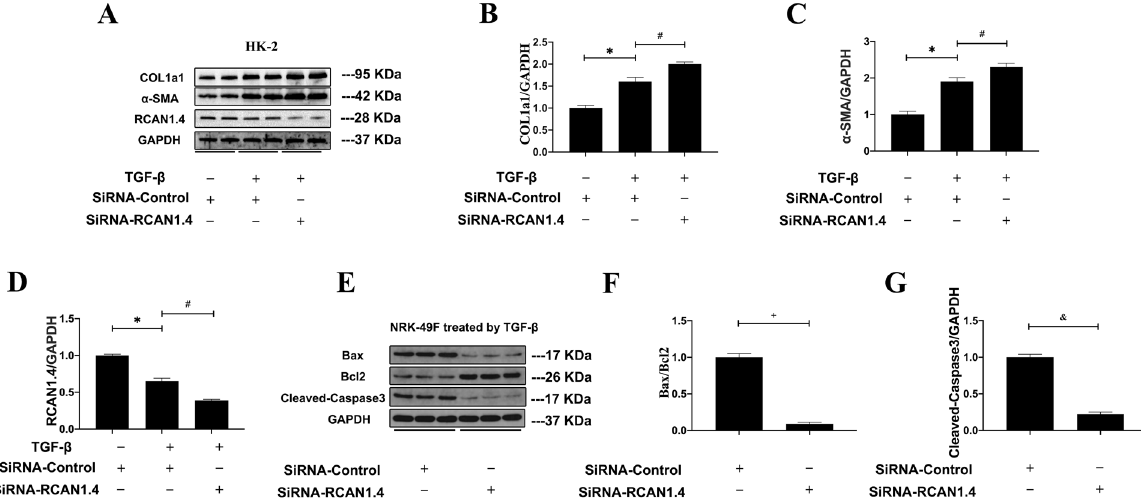
Fig. 5 Further in fl uence of RCAN1.4 silencing in HK-2 cells and NRK-49F cells. A Representative blots of RCAN1.4, COL1a1, α -SMA, and GAPDH; B COL1a1/GAPDH ratio; C α -SMA/GAPDH ratio; D RCAN1.4/GAPDH ratio. E Representative blots of Bax, Bcl-2, cleaved-caspase3 and GAPDH; F Bax/Bcl-2 ratio; G cleaved-caspase3/GAPDH; * p < 0.05, # p < 0.05, + p < 0.01, & p < 0.01, as indicated. The results are expressed as the mean ± standard error of the mean (S.E.M.). for 3 – 4 independent